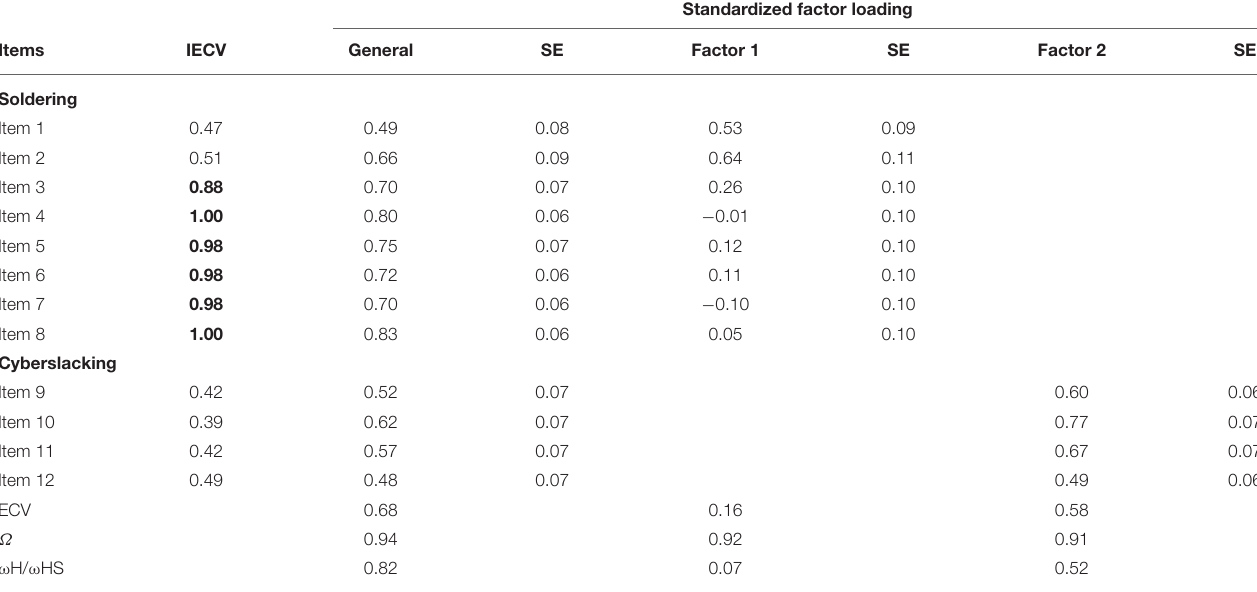
Standardized factor loading